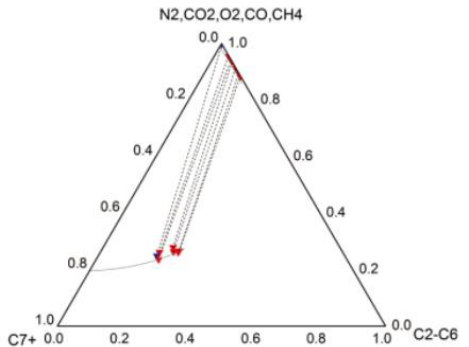
Figure 7—Ternary phase diagram after multiple contact of air bubble and crude